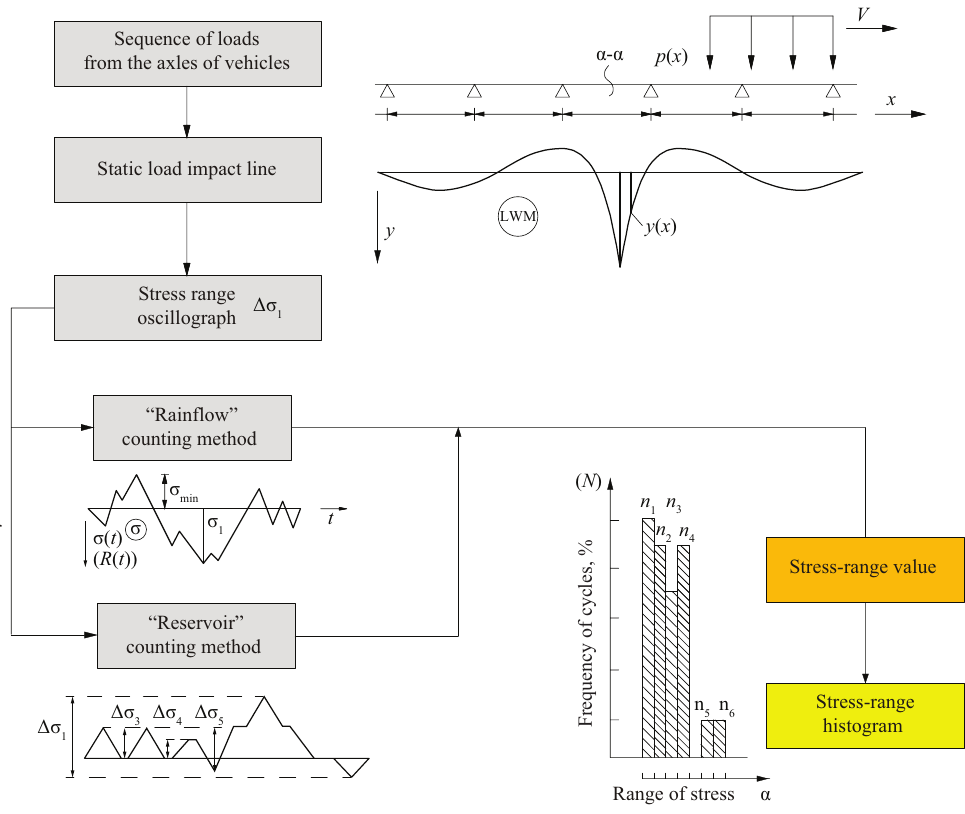
Figure 11. Outline of actions taken in the simulation method for indicating the spectra of strain ranges or